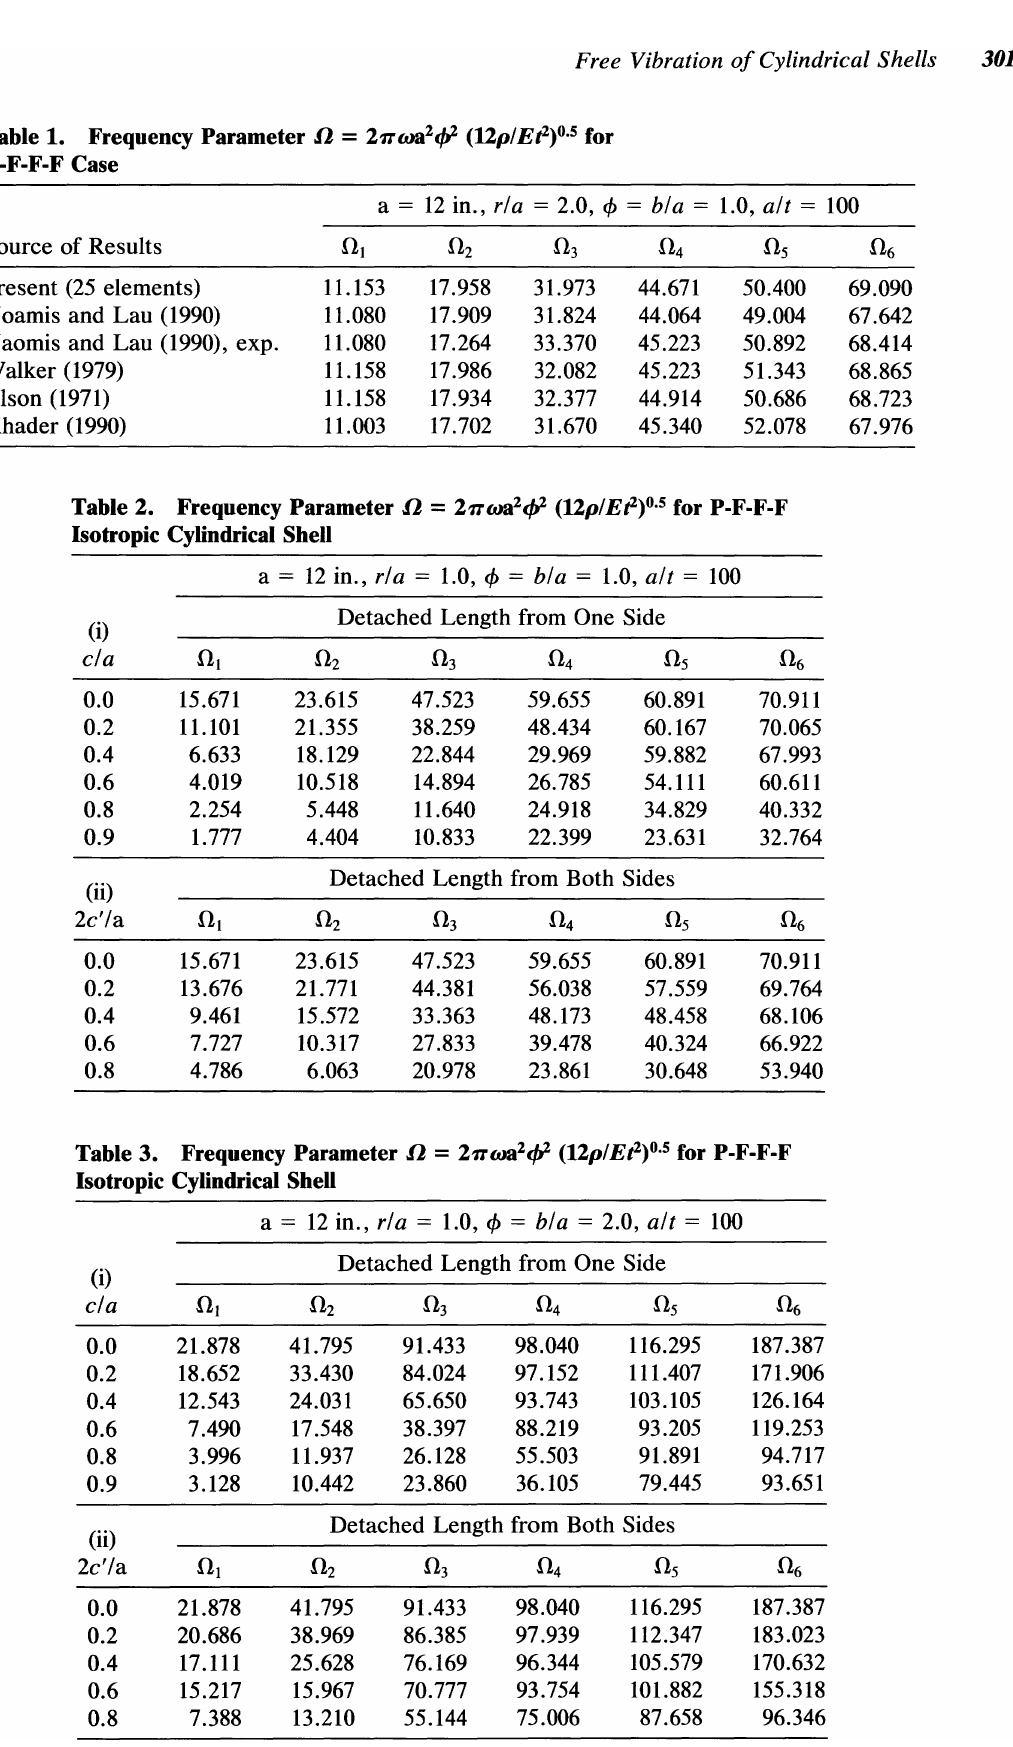
Table 1. Frequency Parameter C-F-F-F Case